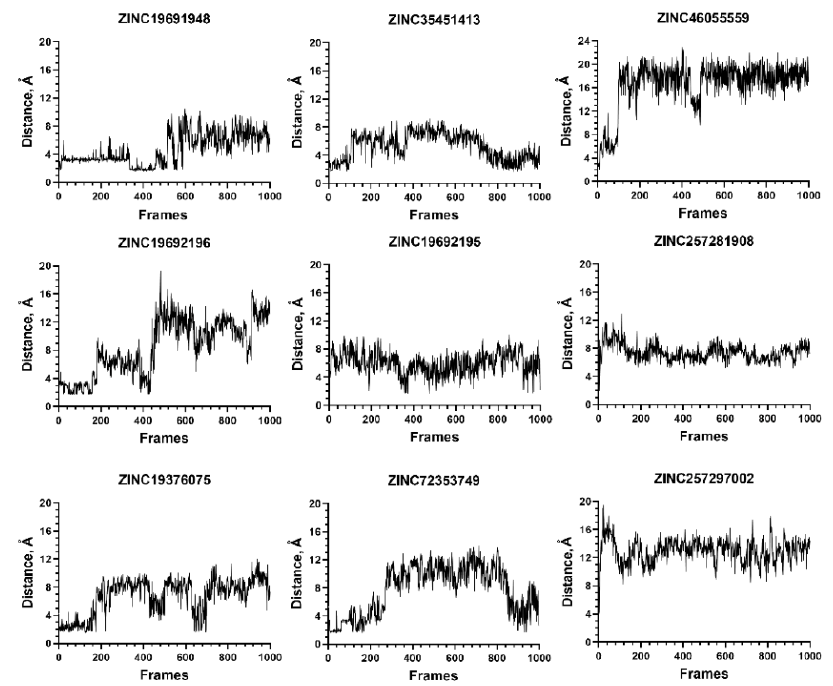
bond was disrupted during the MD simulation (Figure 11).